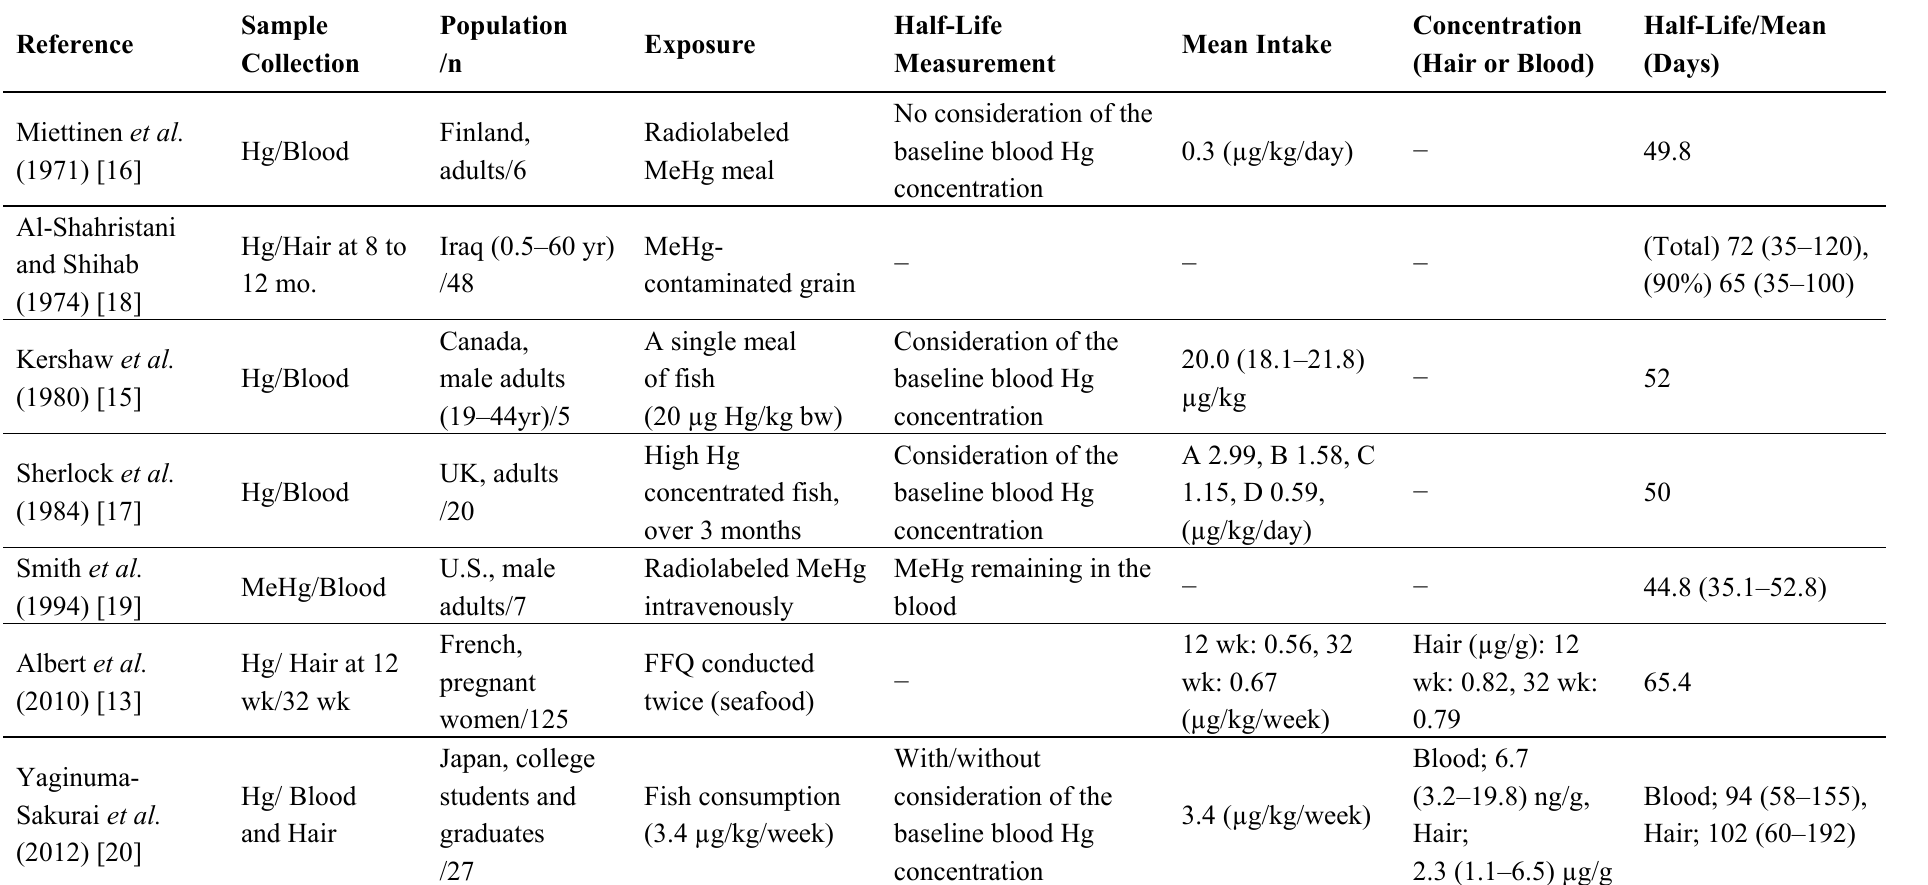
Table 3. Biological half-life of methylmercury given in previous